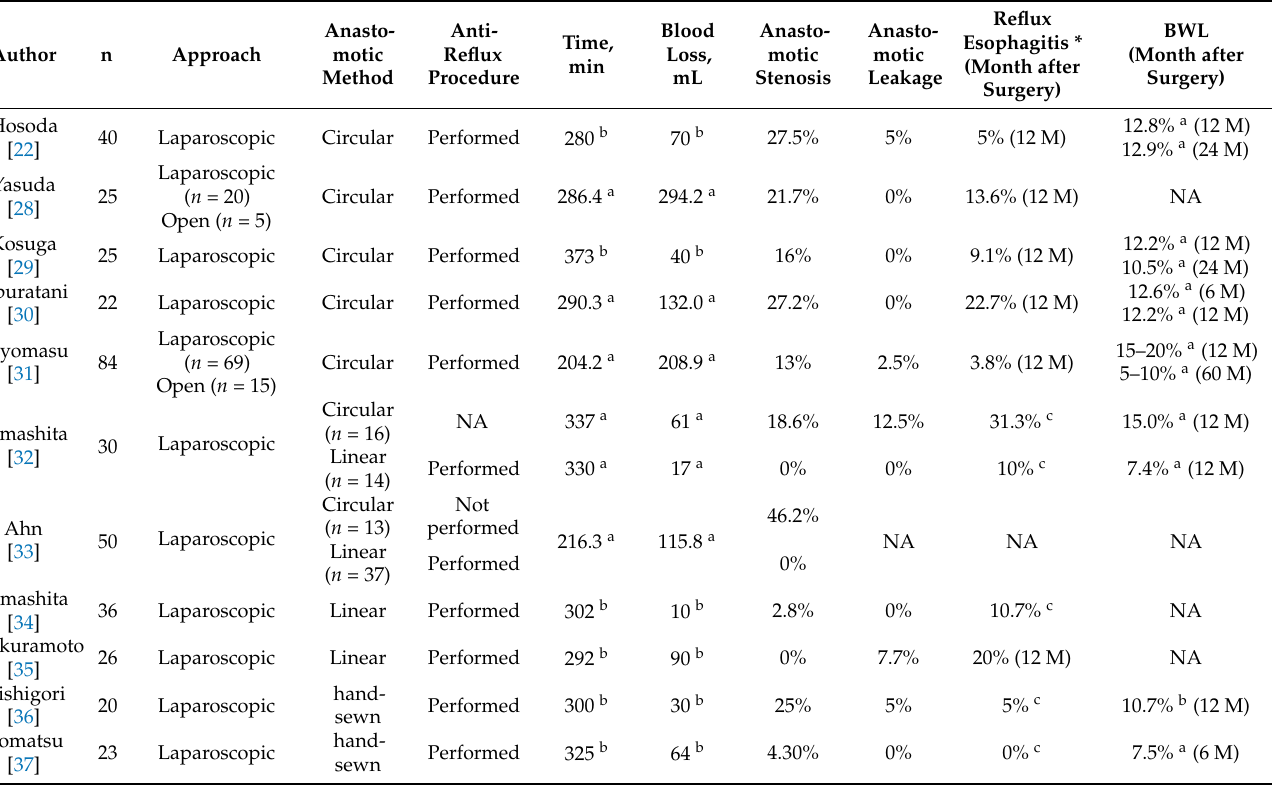
Table 2. Summary of LPG-non-DFT